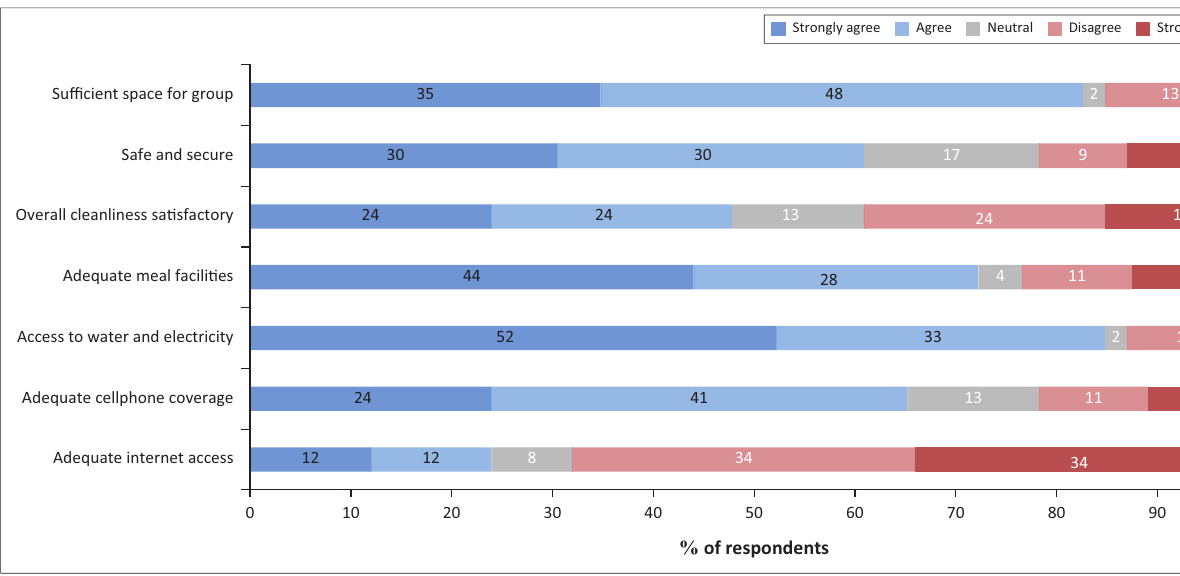
FIGURE 1: Perceptions of accommodation linked to the decentralised clinical training sites.